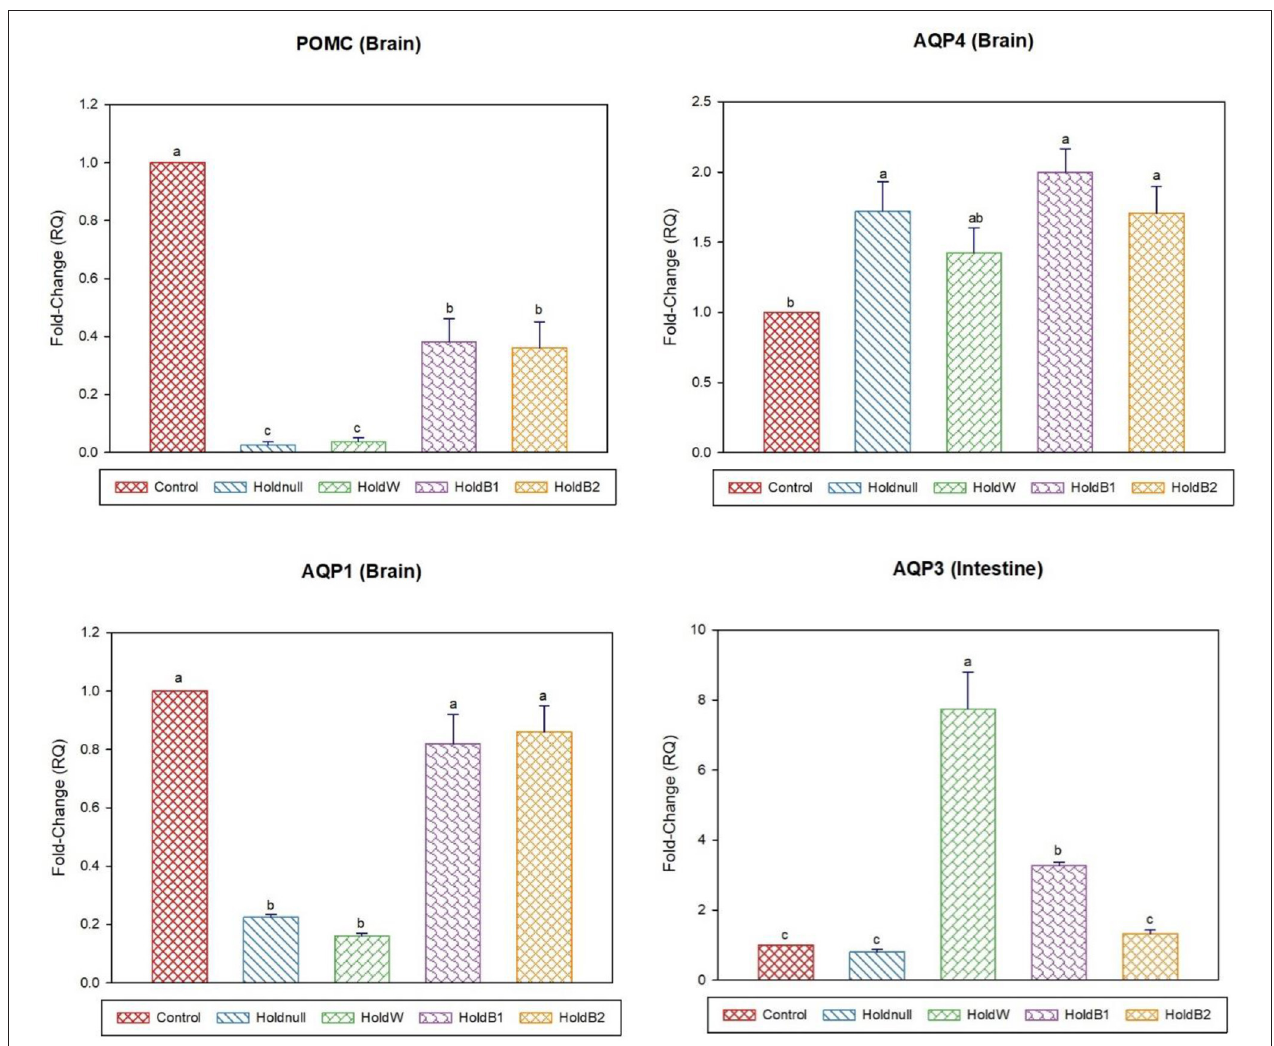
FIGURE 5 | Effect of betaine on the relative expression (fold-change or RQ) of POMC, AQP4, AQP1 in the brain, and AQP3 in the intestine of day-15 old chicks. Control, placed on feed immediately; Holdnull, holding for 48h + no access to feed or water; HoldW, holding for 48h + water only; HoldB1, holding for 48h + water supplemented with betaine (1ml per L); HoldB2, holding for 48h + water supplemented with betaine (2ml per L). Bars with different letters are significantly different ( p < 0.05). Mean ± standard error of the mean, n = 6. AQP, aquaporin; POMC,